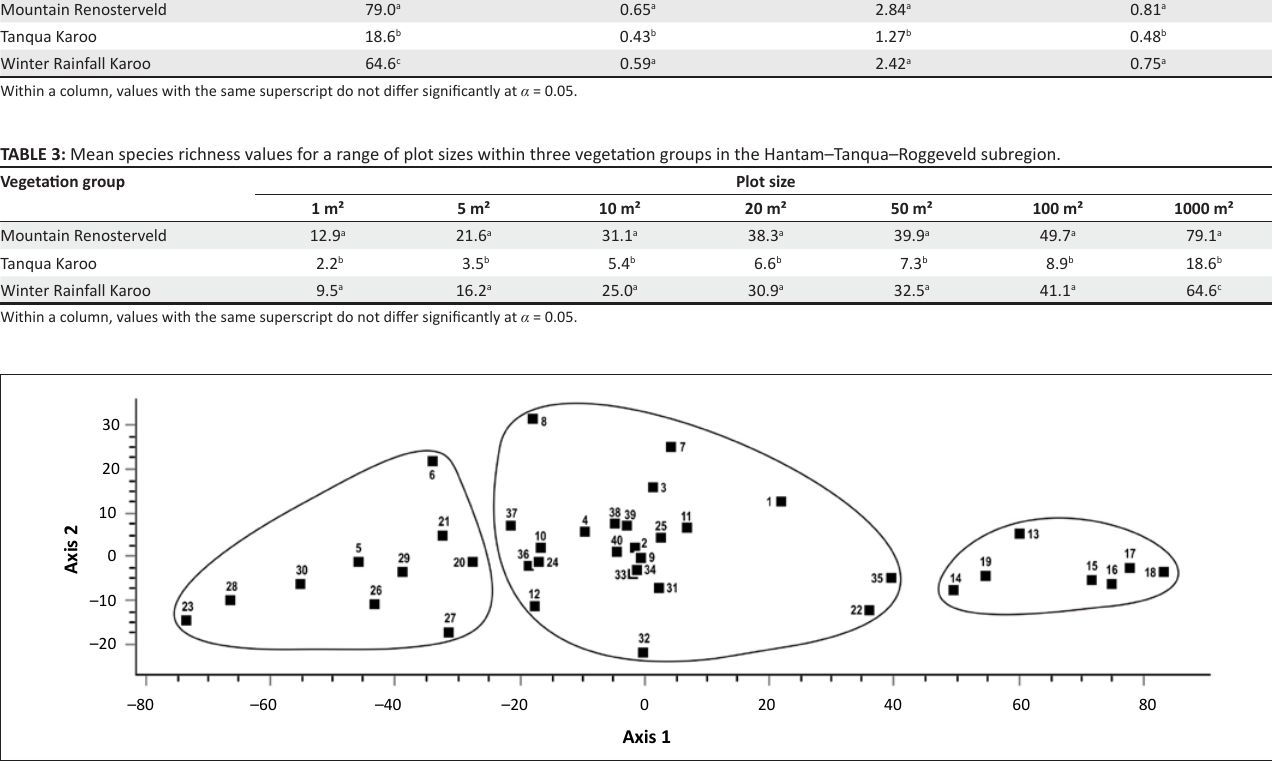
TABLE 2: Mean values and significance for plant diversity parameters within the various identified vegetation groups. Vegetation group